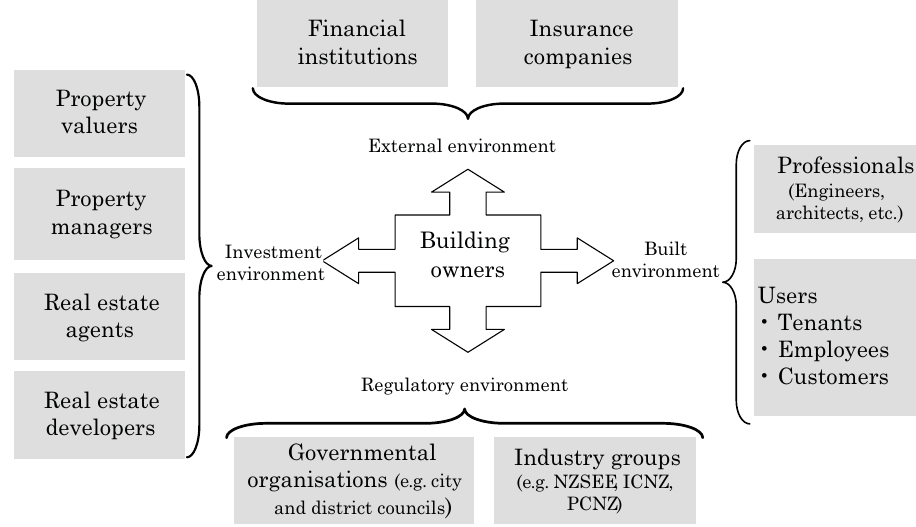
Fig. 1. Stakeholders involved in property market investment and seismic risk mitigation decisions Notes: Zealand Society for Earthquake Engineering (NZSEE); Insurance council of New Zealand (IcNZ); Property council New Zealand